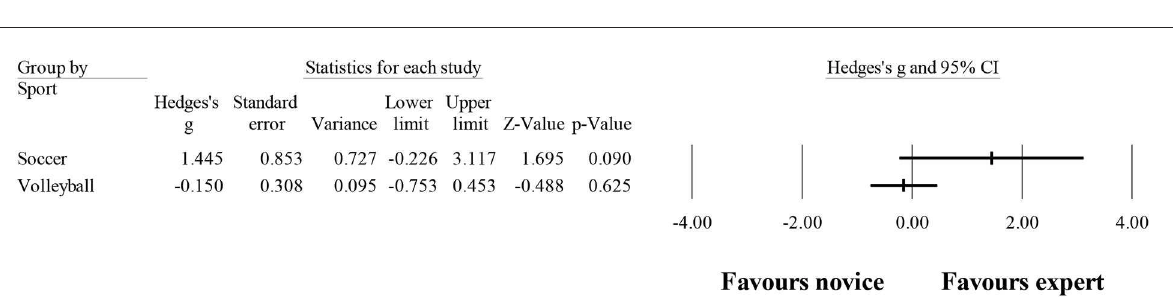
89.3%), and volleyball (four studies; I 2 = 90.1%) athletes. Other